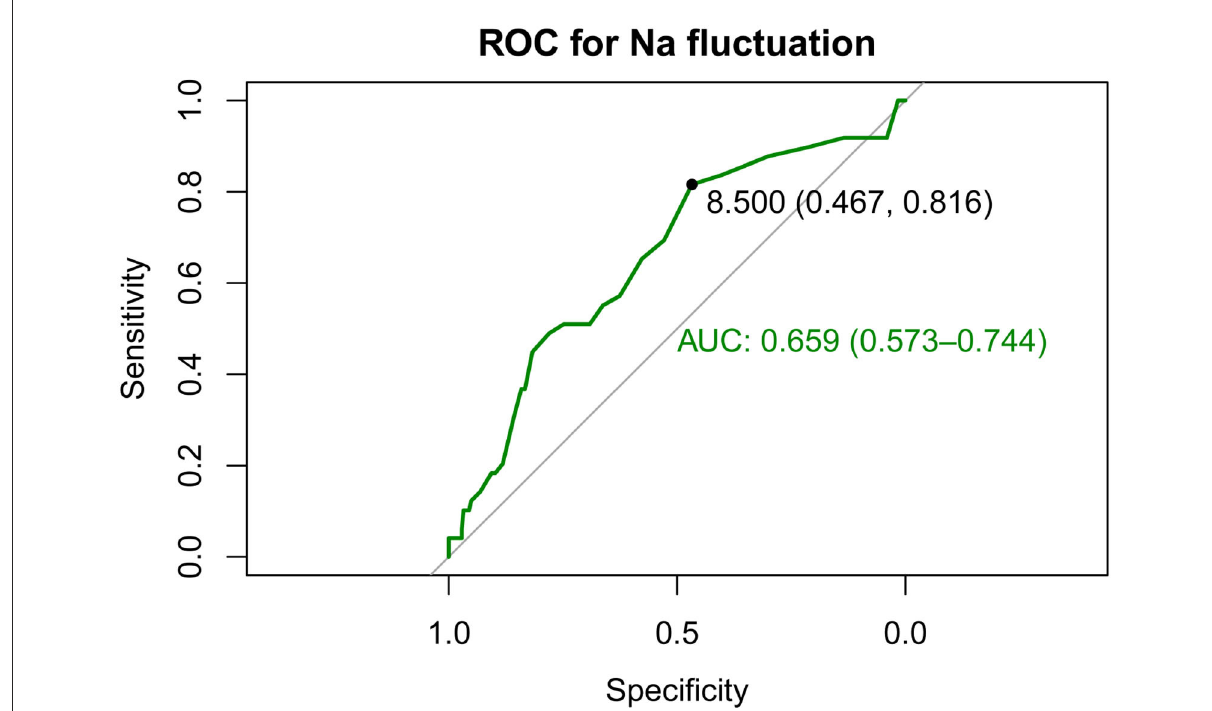
FIGURE3 Receiver operating characteristic (ROC) curves show the specificity and sensitivity and the area under the curve (AUC) for predicting in-hospital death with the sodium fluctuation of patients with spontaneous SAH. SAH, subarachnoid